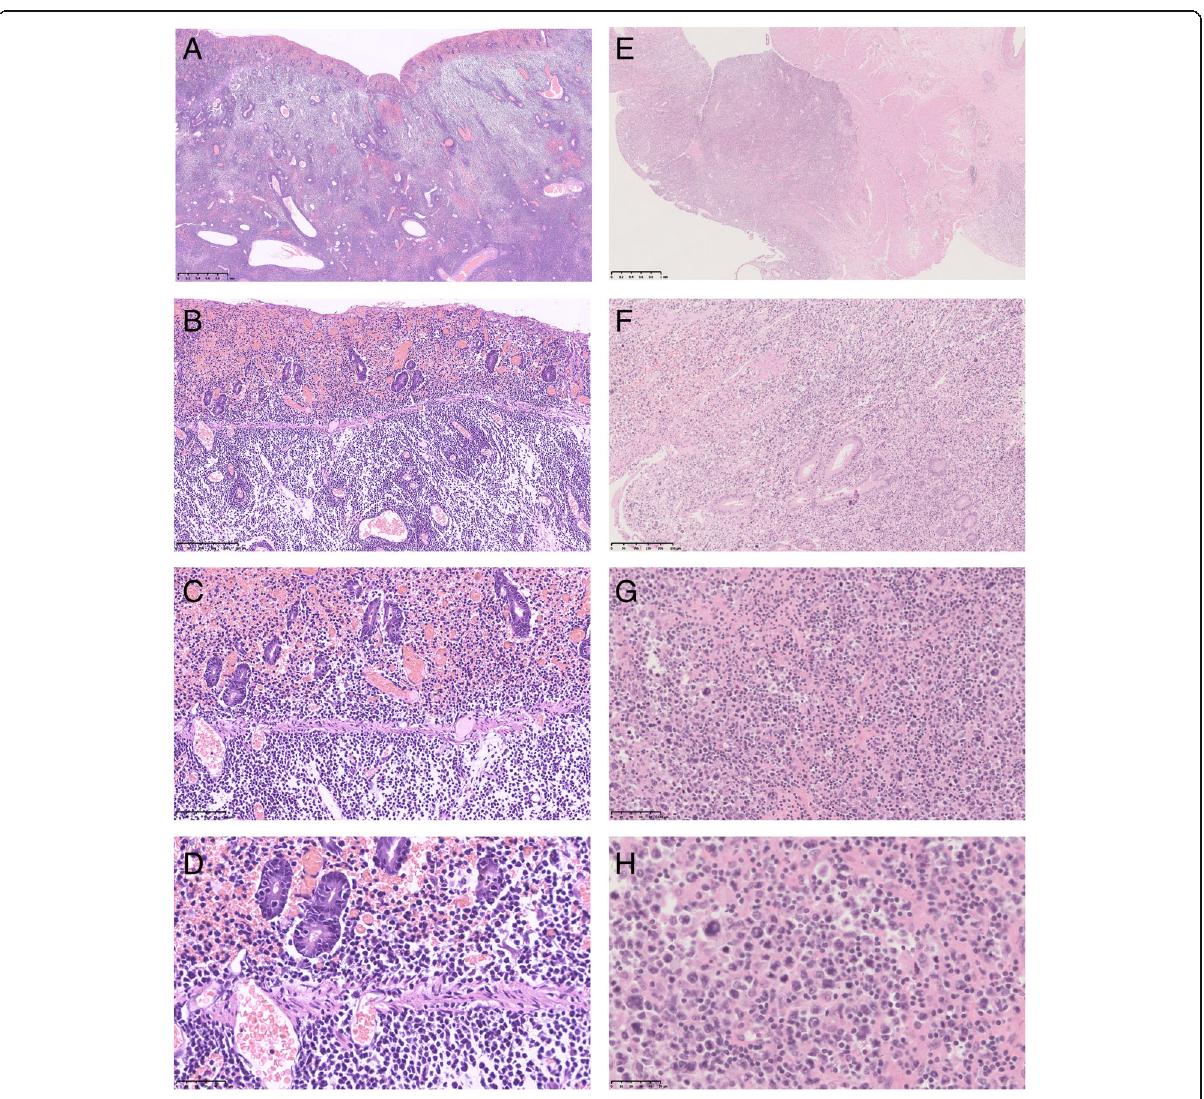
Fig. 1 The morpholgic features of monomorphic epitheliotropic intestinal T ⁃ cell lymphoma. A, E: ×2; B, F: ×10; C, G: ×20; D, H: ×40. A-D epitheliotropic, monomorphic medium-sized tumor cells with round dark nuclei and pale cytoplasm; (E-H) epitheliotropic, polymorphic cells with anaplastic characteristics (large nuclei, obvious nucleoli, increased mitotic activity and nuclear fragmentation) scattered among monomorphic medium-sized